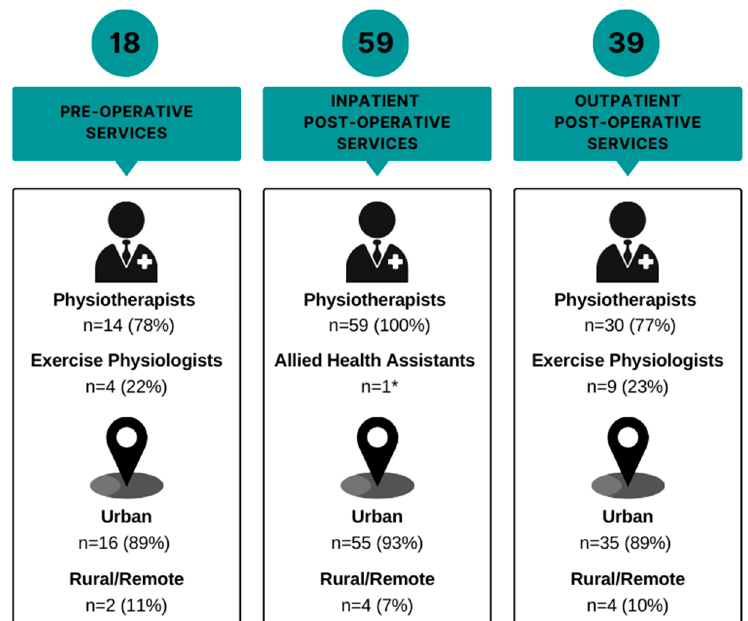
Figure 2. Distribution (number and percentage) of respondent discipline and health service rurality across the continuum of care. * Allied health assistant response received in addition to physiotherapist response from a health service.